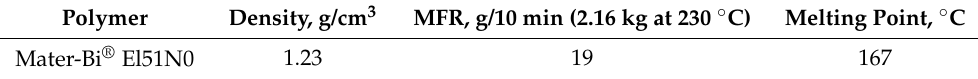
Table 1. Relevant properties of the polymer investigated.